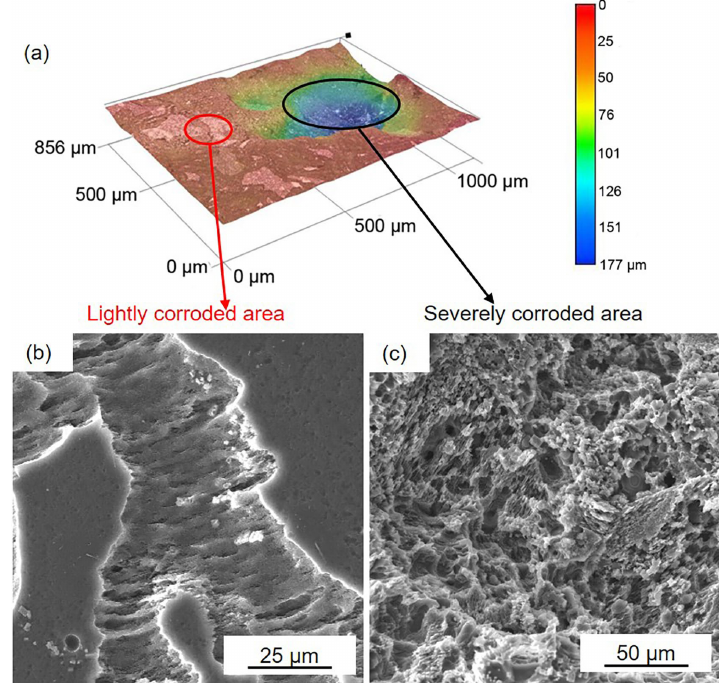
Figure 5. SEM images of the gray areas on the ( a , b ) HOMO and ( c , d ) LPSO samples after 24 h immersion.